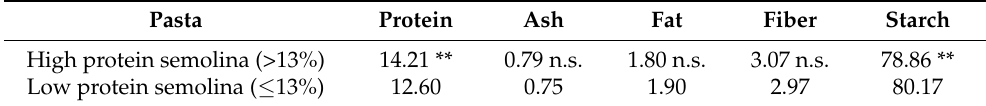
Table 2. Chemical composition of pasta samples. Data are expressed on 100 parts of dry matter. Data are means of 3 replicates. ** ( p < 0.01); n.s. (no significant differences); t -Test. Pasta Protein Ash Fat Fiber Starch High protein semolina (>13%)